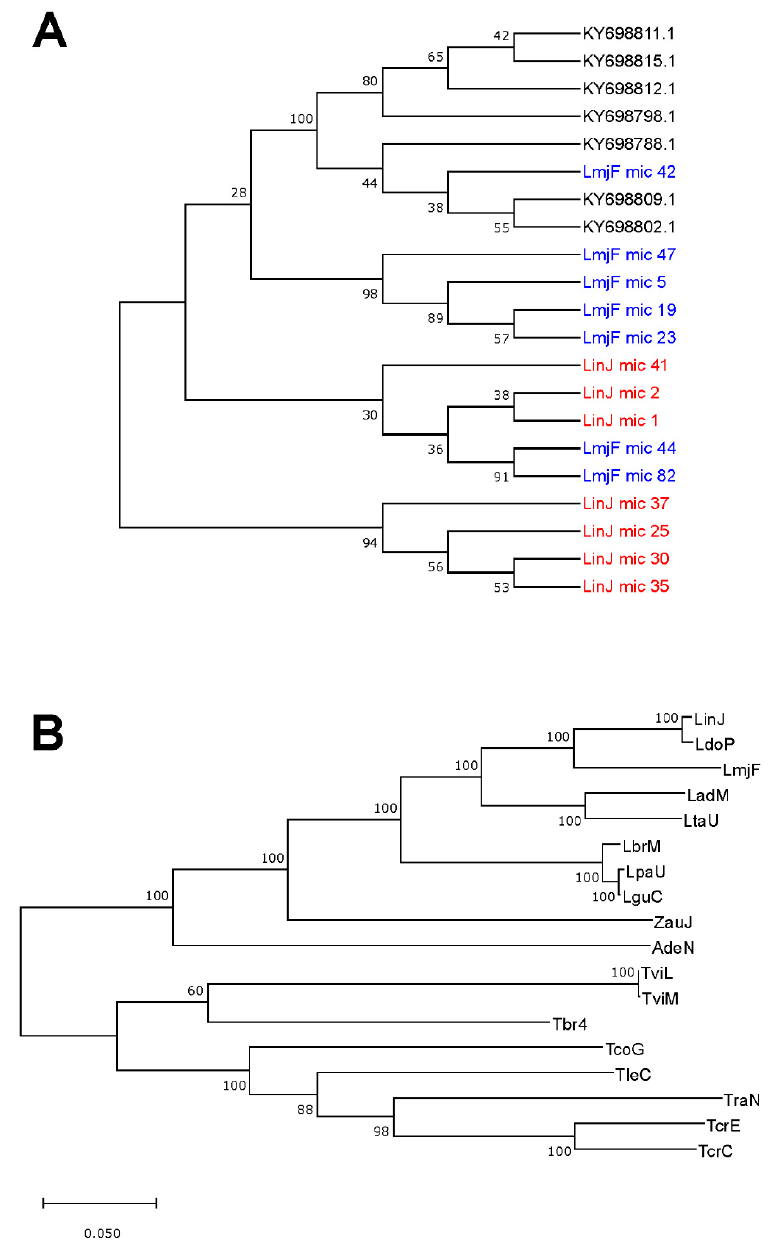
Figure 6. Analysis of the usefulness of minicircle and maxicircle sequences for phylogenetic purposes. ( A ) Phylogenetic tree obtained by sequence comparison of seven minicircles randomly selected for each one of the following species: L. major (LmjF mic), L. infantum (LinJ mic) and L. braziliensis (GenBank accession codes). ( B ) Phylogenetic tree based on the maxicircle sequence of the following trypanosomatids: LinJ, L. infantum (this work); Ldo, L. donovani (GB: CP022652.1); LmjF, L. major (this work); LadM, L. adleri (this work); LtaU, L. tarentolae (GB: M10126.1); LbrM, L. braziliensis (this work); LpaU, L. panamensis (GB: MK570510.1); LguC, L. guyanensis (this work); ZauJ, Zelonia australiensis (GB: MK514117); AdeN, Angomonas deanei (GB: KJ778684.1); TviL (GB: KM386509.1) and TviM (GB: KM386508.1), Trypanosoma vivax ; Tbr4 (GB: M94286.1), T. brucei ; TcoG (GB: MG948557.1), T. copemani ; TleC (GB: KR072974.1), T. lewisi ; TraN (GB: KJ803830.1), T. rangeli ; TcrE (GB: DQ343646.1) and TcrC (GB: DQ343645.1), T. cruzi . The phylogenetic analyses were carried out as indicated in the legend of Figure 5. The log likelihood of the trees shown in A and B was –16227.07 and –143206.12, respectively. The percentage of trees in which the associated taxa clustered together is shown next to the branches (bootstrap values were obtained from 500